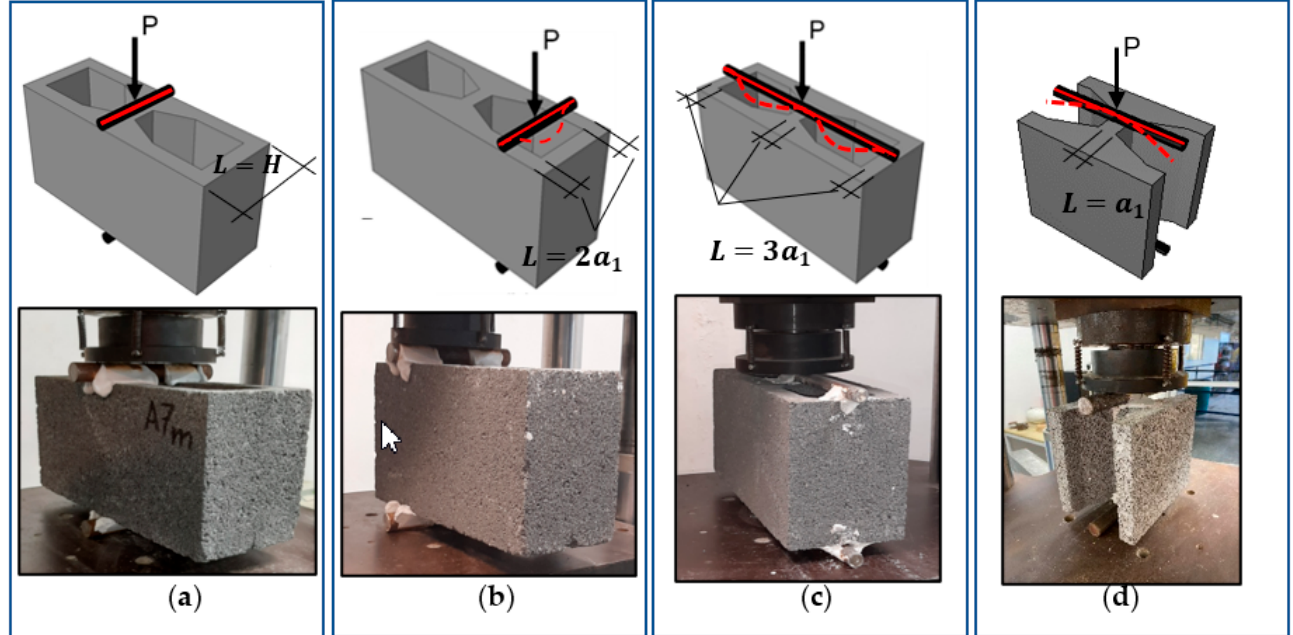
Figure 4. Arrangement for splitting tests: ( a ) x-direction over the gross area, ( b ) x-direction over the net area, ( c ) y-direction, and ( d ) 200 mm from the central region of the block in the y-direction (mod- ified